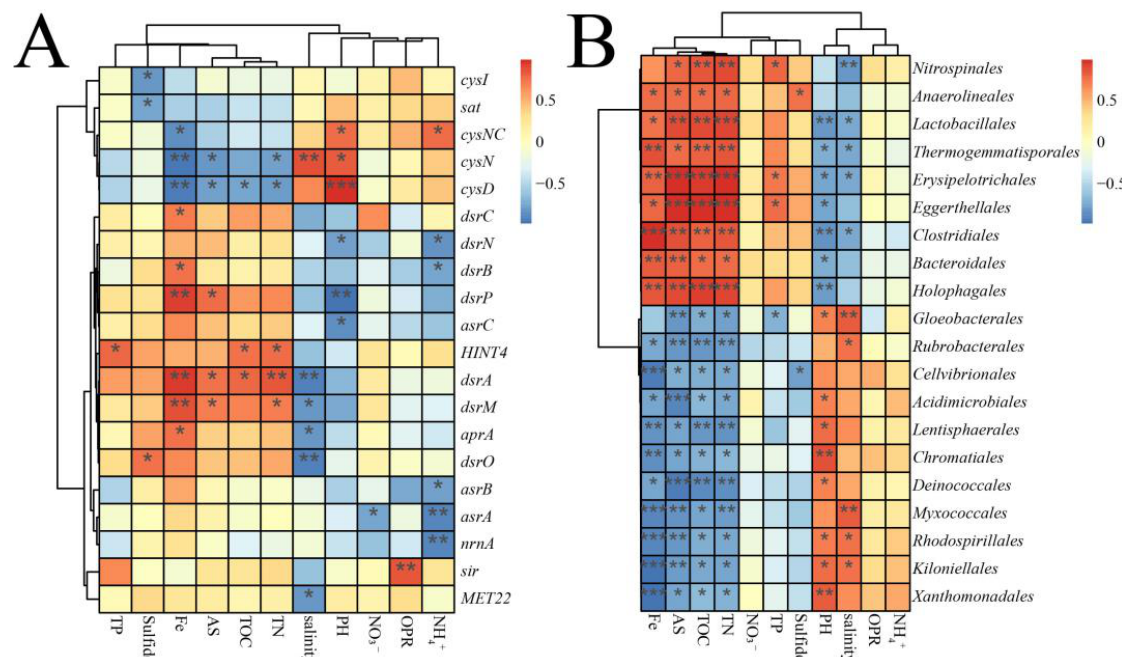
Figure 5. ( A ) Correlation heat map according to the z -scores of the 20 most abundant dissimilatory sulfate-reducing gene (sub)families with significant correlation among sediment properties. ( B ) Correlation heat map according to the z -scores of the 20 most abundant microbial communities with significant correlation among sediment properties. * p < 0.05, ** p < 0.01, *** p <